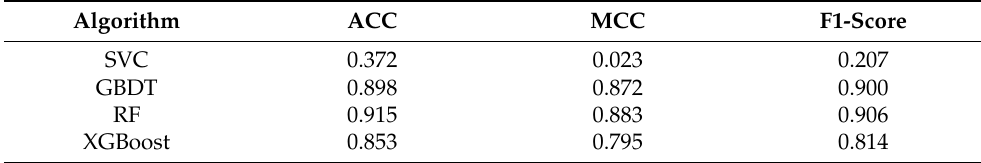
Table 3. Classification results of crystal systems on the four ML test sets.